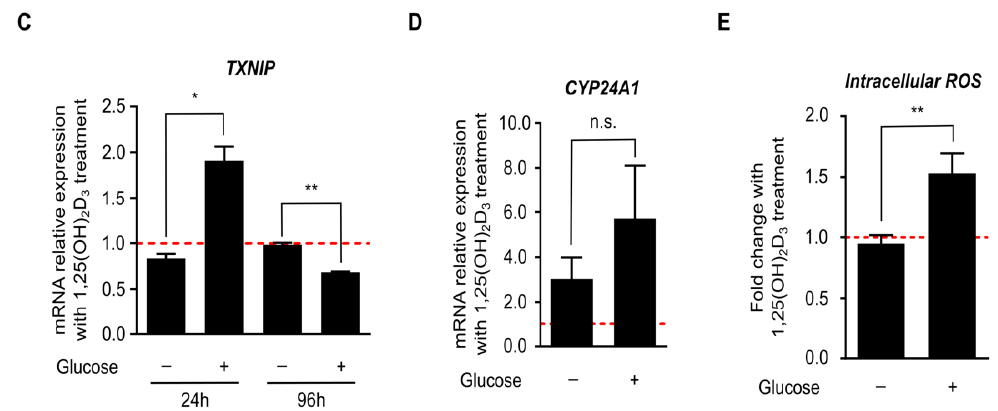
Figure 3. Regulation of TXNIP expression and redox balance in HL-60 cells by 1,25(OH) 2 D 3 is glucose-dependent. ( A , B ) Immunoblots showing TXNIP protein levels. ( A ) In the absence of glucose, expression of TXNIP in HL-60 cells is significantly reduced, and appears to be unaffected by 1,25(OH) 2 D 3 (100 nM) treatment. “+” and “ − ” denote the presence or absence of the indicated molecule/treatment, respectively; ( B ) In the presence of a single high dose of the glucose uptake inhibitor phloretin (200 µ M), added at different time intervals prior to the end of the initial treatment period (24 h), 1,25(OH) 2 D 3 is found to be incapable of inducing TXNIP expression; ( C ) Changes in TXNIP mRNA levels after 24 and 96 h of treatment with 1,25(OH) 2 D 3 in HL-60 cells, cultured in the presence or absence of glucose, reveal that regulation by 1,25(OH) 2 D 3 is glucose-dependent. The dashed red line indicates baseline mRNA expression in DMSO-treated cells set to 1. Error bars ± SD; n = 2; ( D ) Unlike TXNIP, the 1,25(OH) 2 D 3 target gene CYP24A1, is induced in response to 1,25(OH) 2 D 3 treatment (96 h) independent of glucose availability. Error bars ± SD; n = 2; ( E ) In absence of glucose, intracellular ROS levels are largely unaltered upon treatment of HL-60 cells for 96 h with 1,25(OH) 2 D 3 . The dashed red line indicates basal ROS levels in DMSO-treated cells set to 1. Statistical significance was calculated using a two-tailed Student’s t-test, with p-values less than or equal to 0.05 and 0.01 depicted by * and **, respectively. Nonsignificant results are denoted as n.s. Error bars ± SD; n =